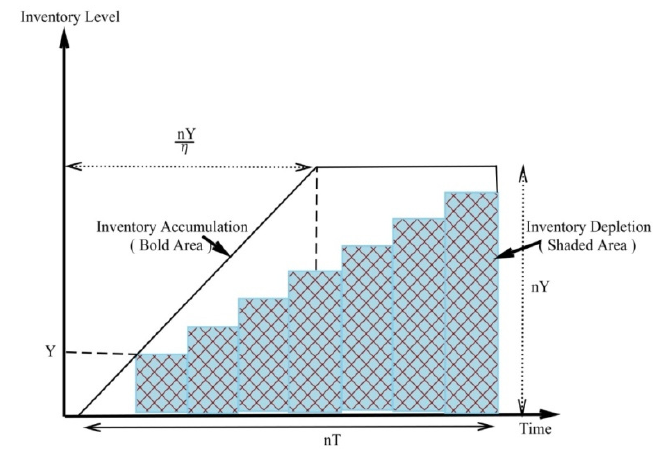
Figure 6. Explanation of the vendor’s holding cost.